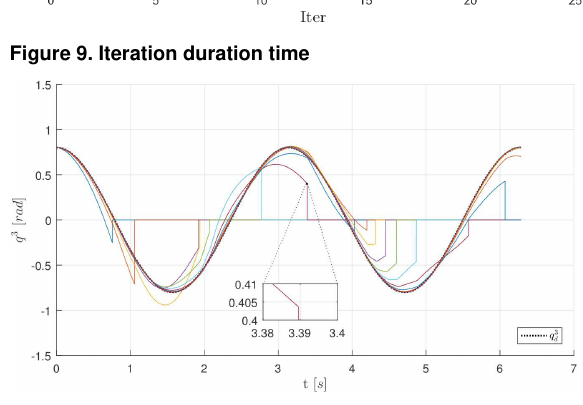
Figure 10.Trajectory tracking q 3 through iterations - BEA